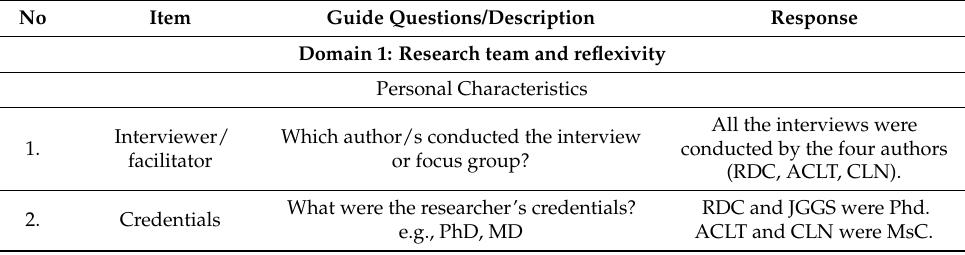
Table A2. Consolidated criteria for reporting qualitative studies (COREQ): 32-item checklist.